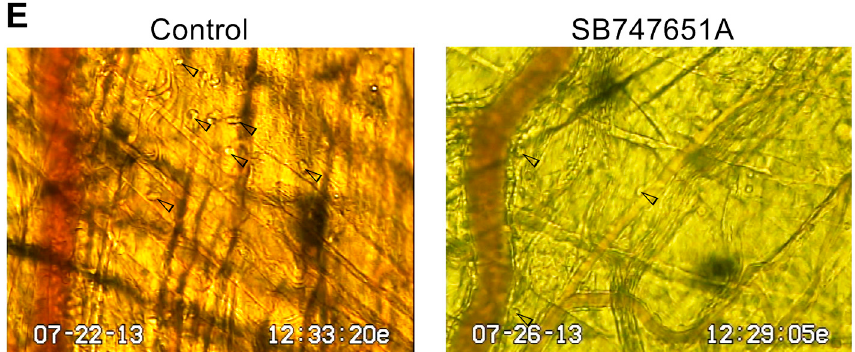
Figure 2. Effect of SB-747651A on CXCL2-induced neutrophil adhesion and emigration. ( A ) Time course of the number of adherent neutrophils (cells/100-µm venule) and ( B ) time course of the number of emigrated neutrophils (cells/235 × 208 µm 2 field) induced by CXCL2 in the absence (Control) or in the presence of MSK1 inhibitor SB-747651A (5 µM) 30 min prior to and 60 min following the placement of CXCL2-containing gel. Data are means ± SEM ( n = 4). *, ** and *** indicate significant difference ( p < 0.05, p < 0.01 and p < 0.001, respectively) from the Control. ( C ) Time course of the number of adherent neutrophils (cells/100-µm venule) and ( D ) time course of the number of emigrated neutrophils (cells/443 × 286 µm 2 field) induced by CXCL2 in the absence (Control) or in the presence of MSK1 inhibitor SB-747651A (3 mg/kg, intrascrotal injection, 1-h prior to CXCL2 treatment) at 3.5–4.5 h following an intrascrotal injection of 0.2 µg CXCL2. Data are means ± SEM ( n = 3). *** indicates significant difference ( p < 0.001) from the Control. ( E ) Representative images from intravital video microscopy showing a postcapillary venule ( Left ) and the surrounding cremaster muscle with emigrated neutrophils (arrow head) at 60 min induced by CXCL2 in the absence (Control) or in the presence of MSK1 inhibitor SB-747651A (5 µM) 30 min prior to and 60 min following the placement of CXCL2-containing gel ( Right ).